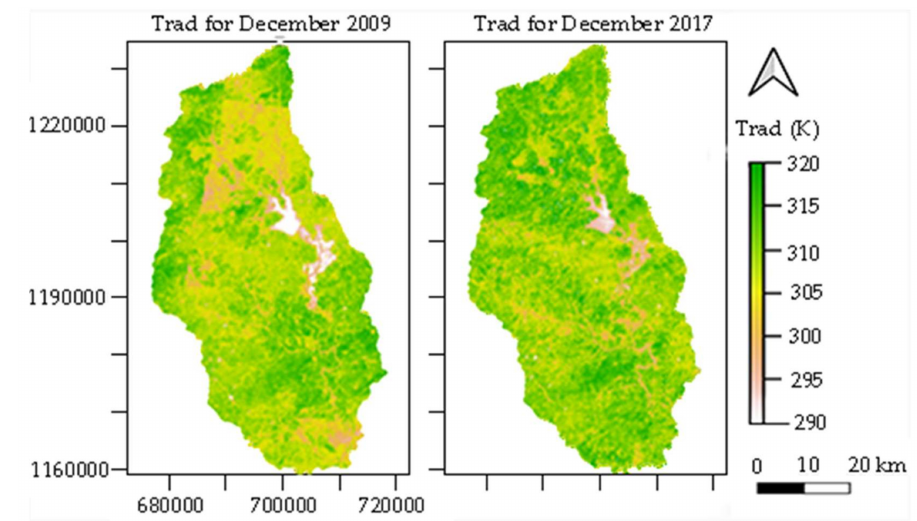
Figure 5. ASTER-derived surface radiometric temperatures (T rad ) at the study field.